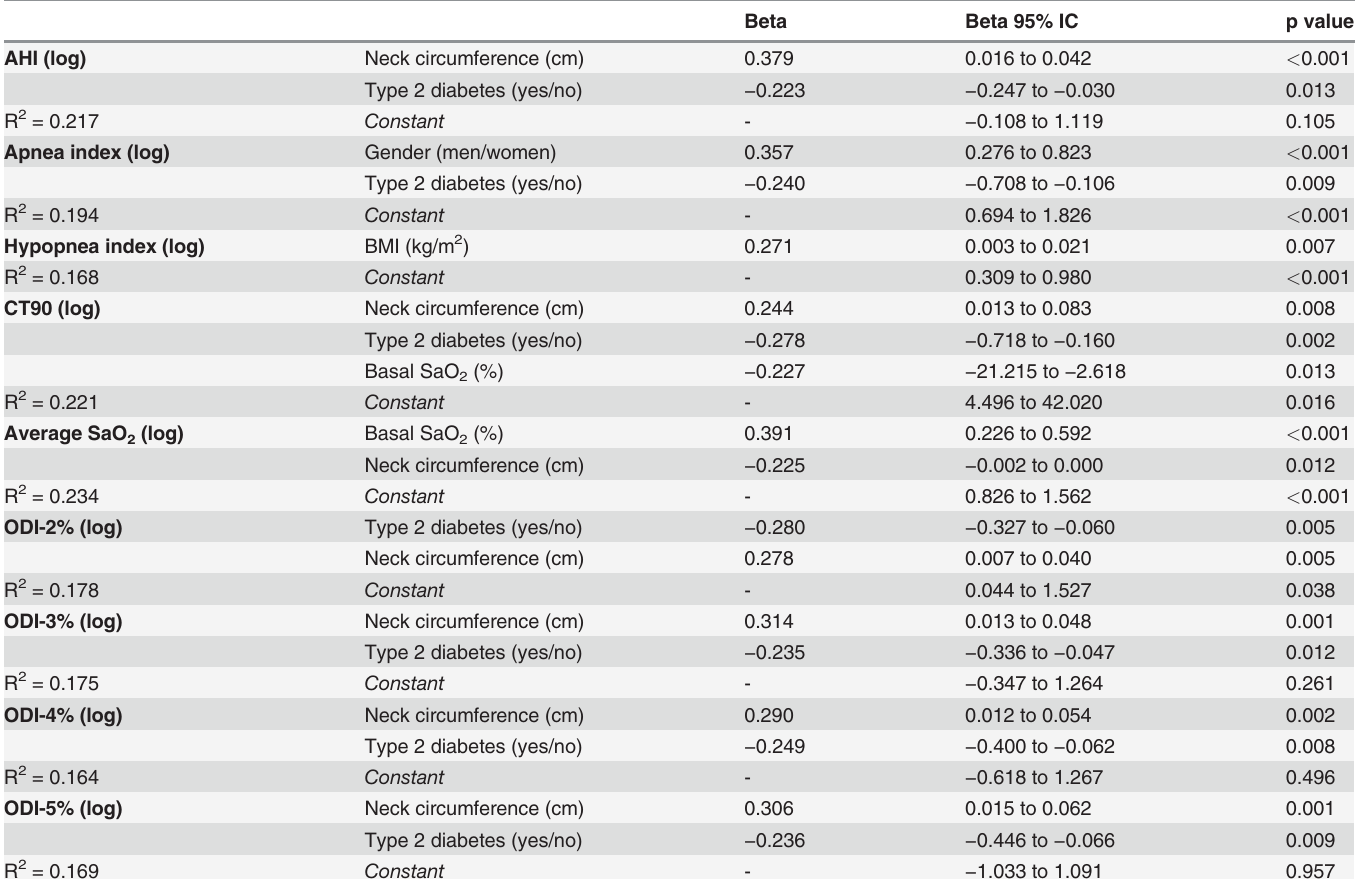
Table 4. Stepwise multiple linear regression analysis of variables associated with parameters obtained from the polysomnographic study in the whole population (n = 393